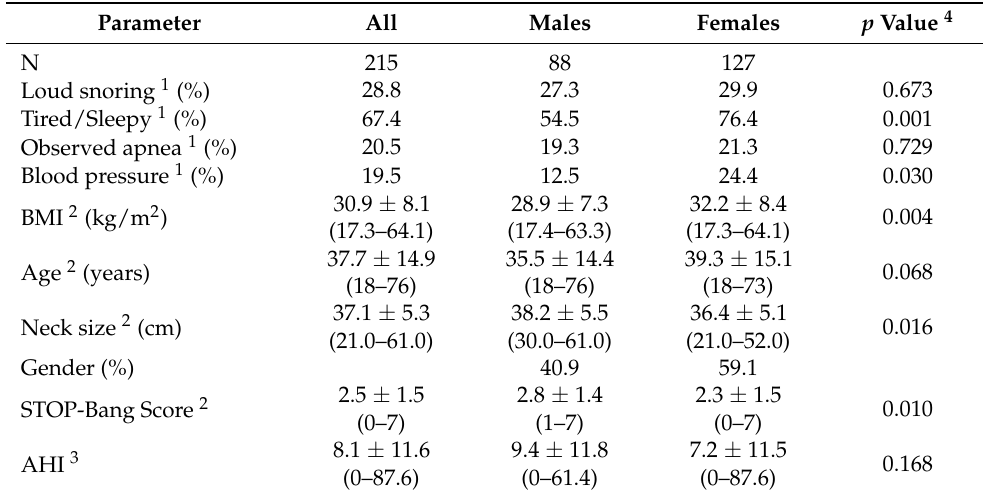
Table 1. Summary Statistics of the participant